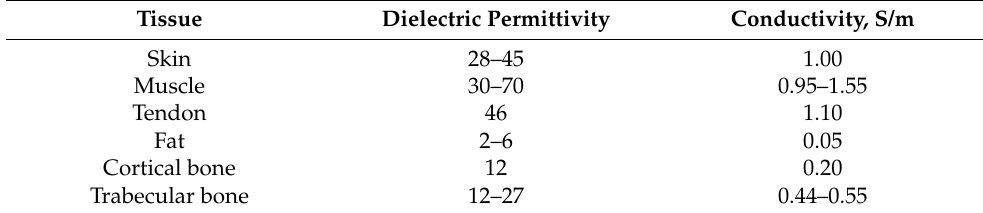
Table 1. Electric properties of different biological